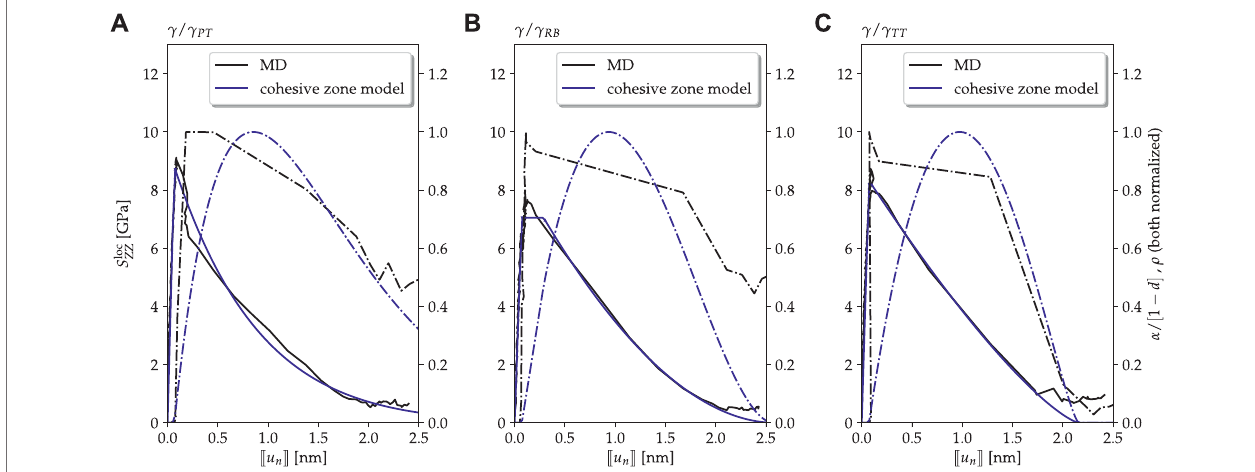
FIGURE 7 | Defect-free case (Type-1 interface model): traction – separation curves as observed in MD simulations (solid black lines) compared to the ones of cohesive zone models with parameters fi tted to the results of the MD simulations (solid blue lines) at a temperature T (cid:2) 900 K and strain rate _ ε glo ZZ (cid:2) 10 9 / s for the three different γ / γ interfaces (i.e., (A) c / c PT , (B) c / c RB , and (C) c / c TT ).The dashed lines denote the normalized dislocation density ρ observed inMD simulations(black) and the normalized damage-corrected interface plasticity α / [ 1 − d ] in the cohesive zone model